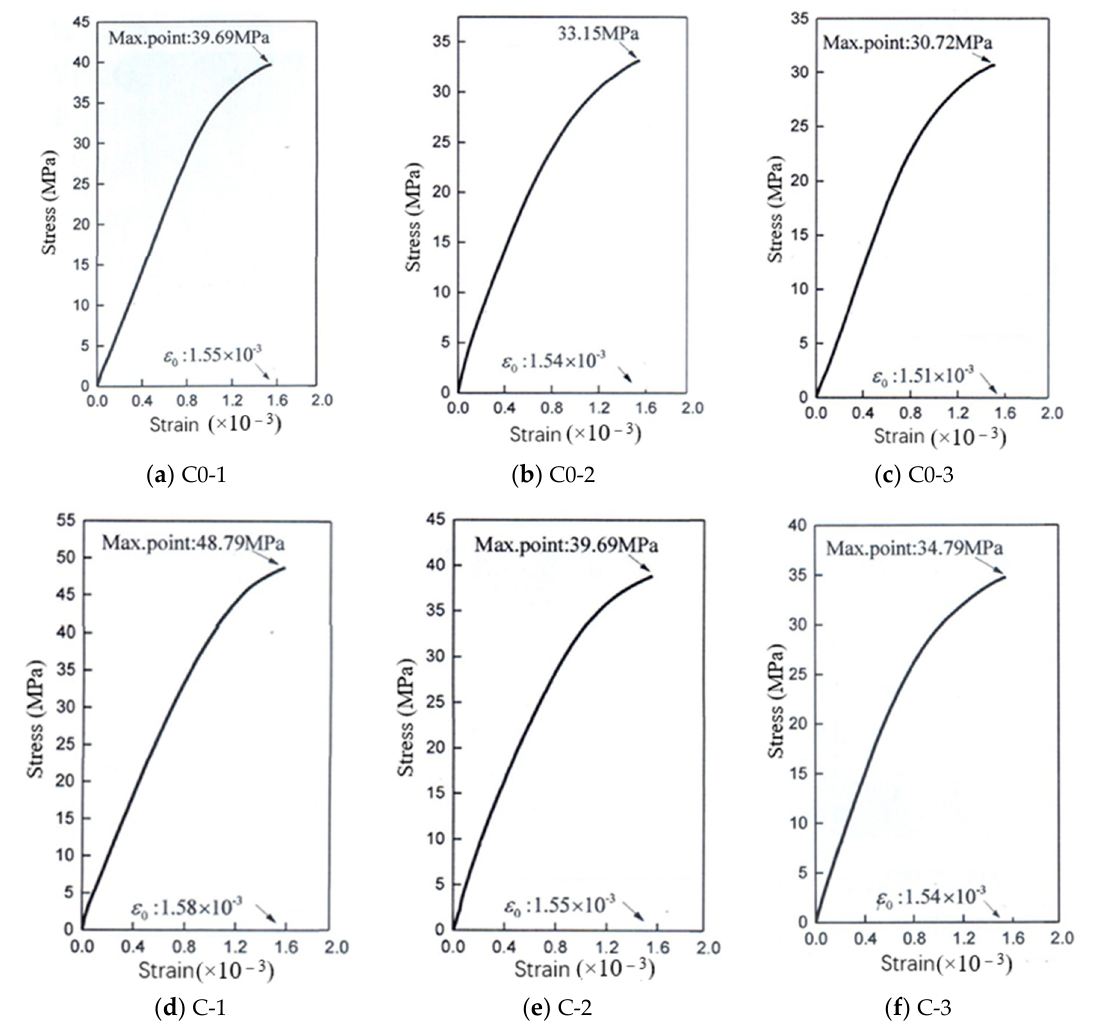
Figure 4. The relationship between stress and strain of concrete.